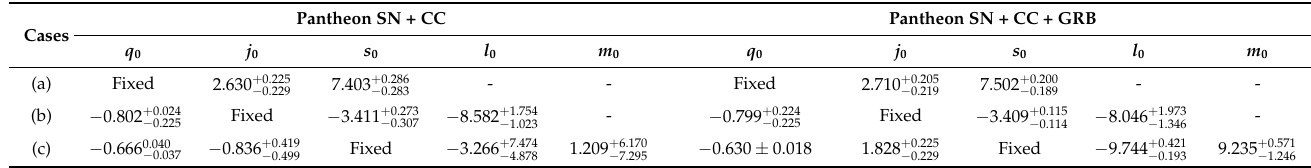
Table 1. Best cosmographic fits for the standard case using a f ( T , B ) power law model. In first columns are denoted the three cases considered. We divided the analysis using: Pantheon SN + CC (second block column) and Pantheon SN + CC + GRB (third block column). The word fixed indicates a flat Λ CDM prior imposed on each case. Results are discussed in the